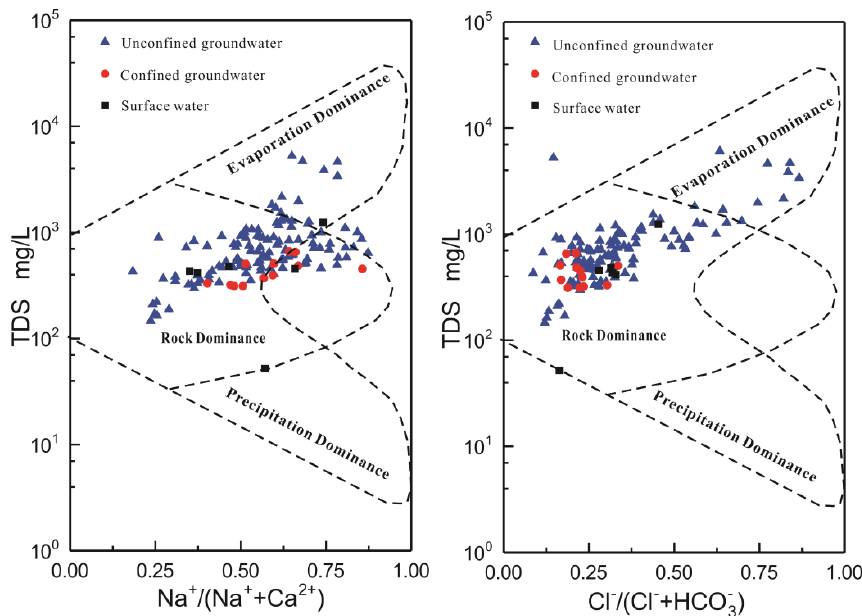
Figure 5. Gibbs diagrams for the major-ion composition of the groundwater in the Delingha area.